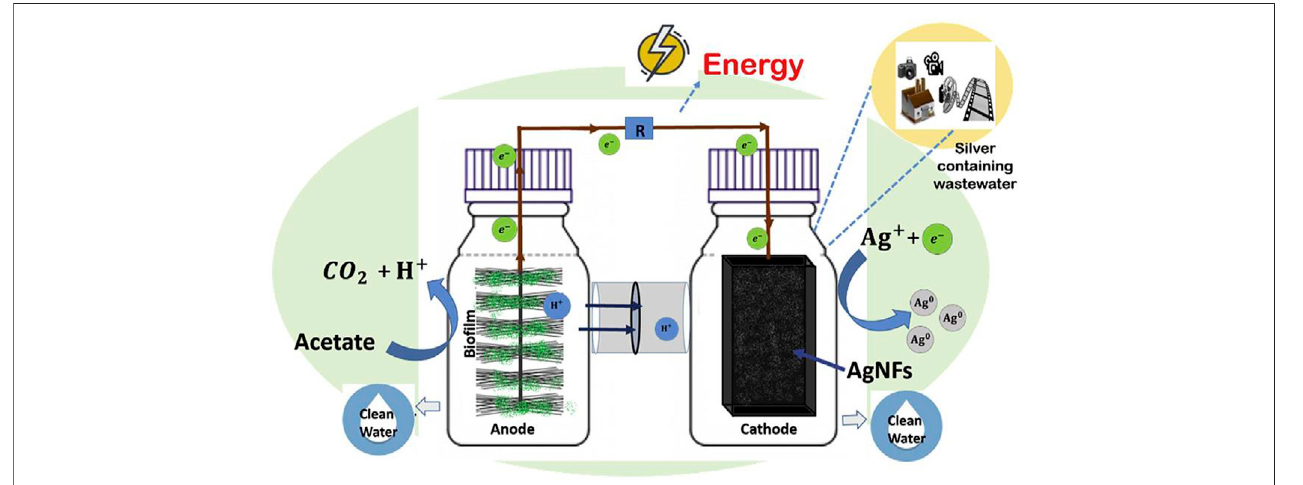
FIGURE 8 | The MFC operation principle and components are depicted in a schematic diagram (Ali et al.,